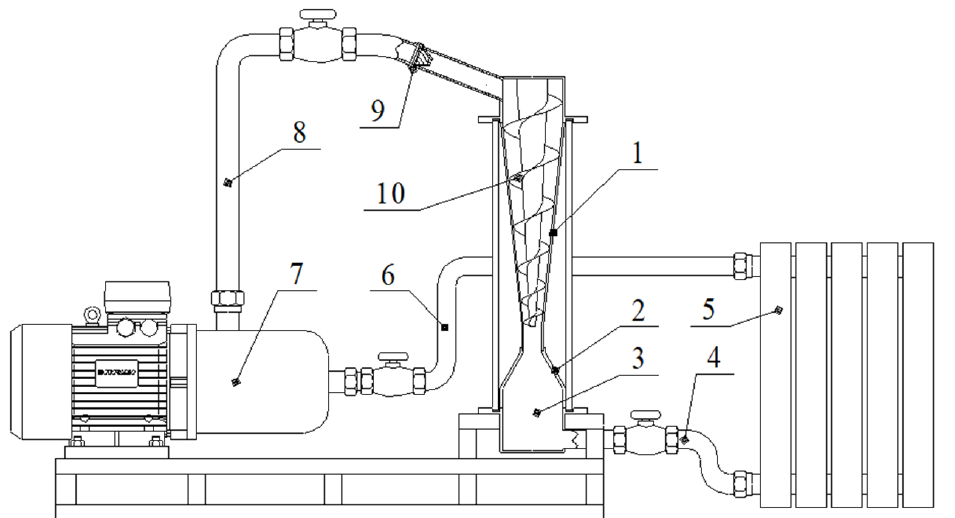
Figure 4. Structural design of the vortex heat generator: (1) main body (confuser); (2) diffusor; (3) cushion chamber; (4) export pipeline; (5) heat exchanger; (6) return pipeline; (7) pump; (8) supply pipeline; (9) turbulizing nozzle; (10) vortex flow accelerator.